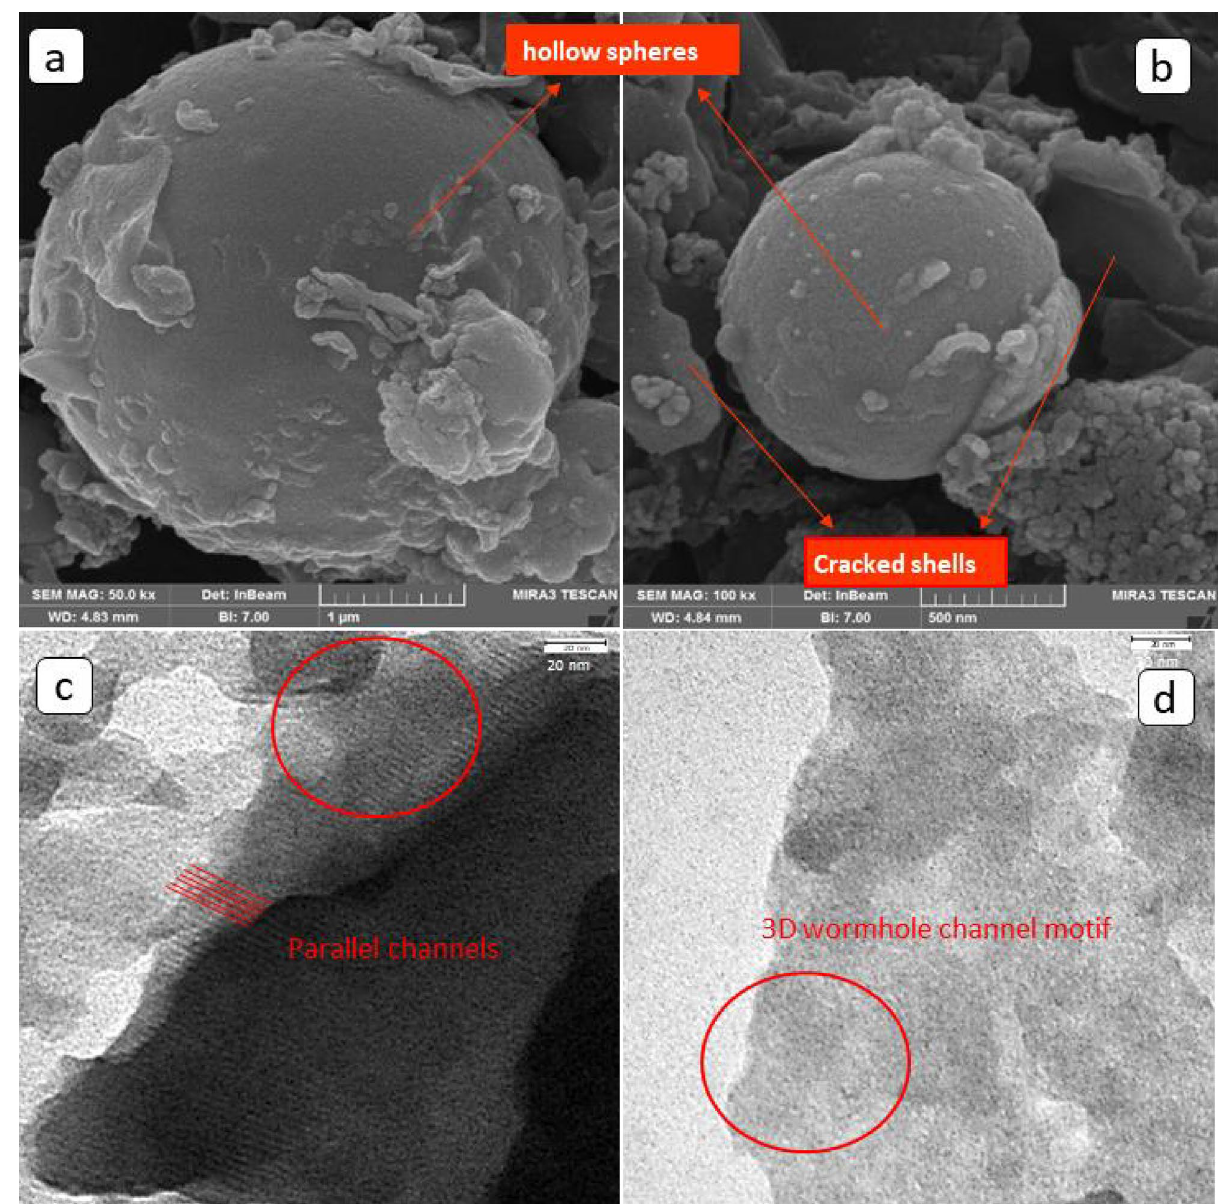
Figure 2. FESEM images ( a and b ), and TEM images ( c and d ) of the synthesized